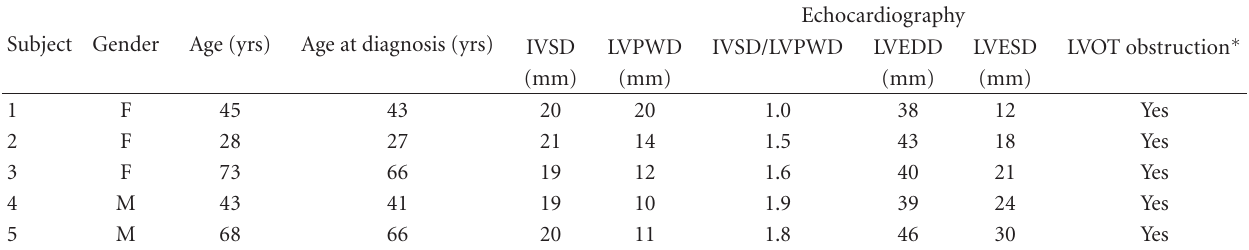
Table 1: Clinical and echocardiography characteristics of patients with hypertrophic